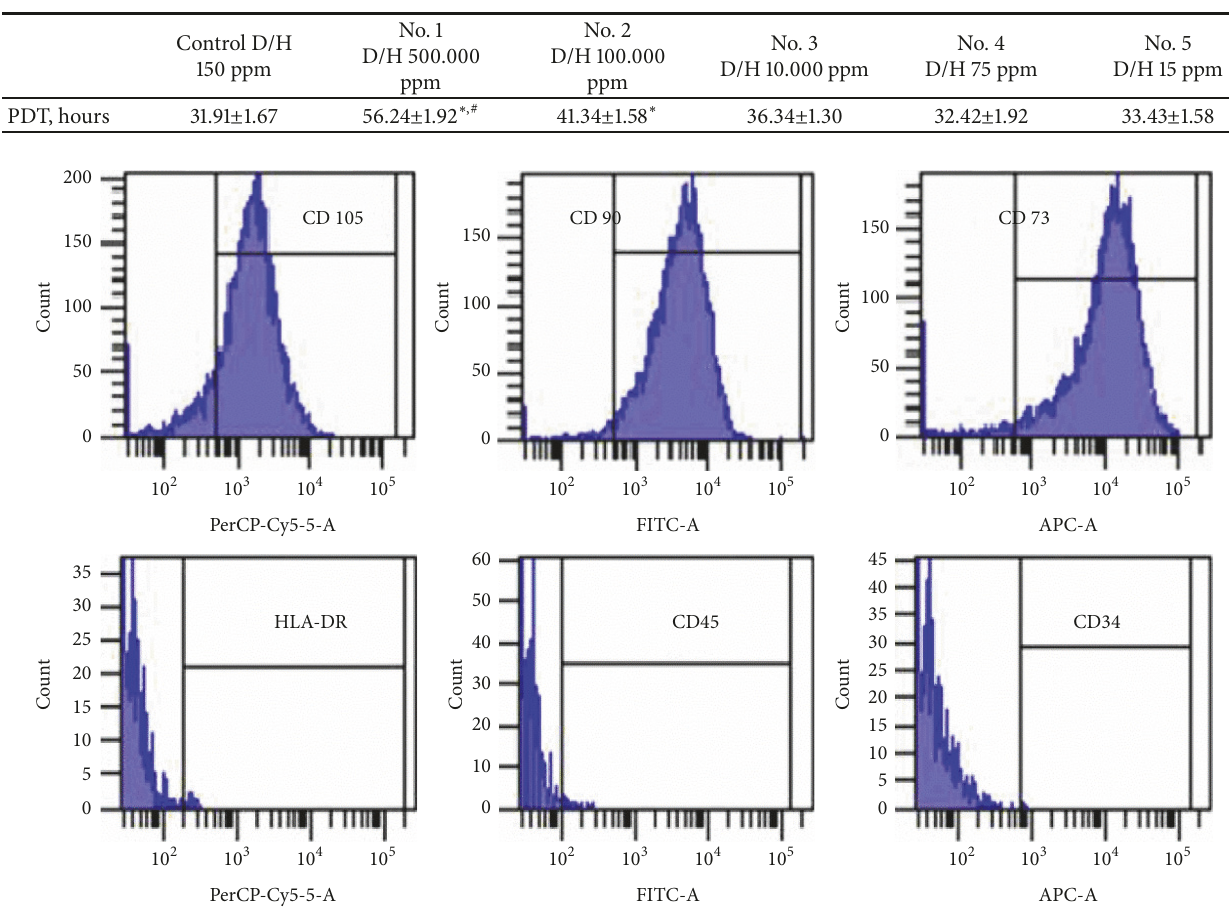
Table 2: ADSCs PDT in growth media with different deuterium content.Theresults are expressed as mean ± SD (n=6), significant differences between the experimental group ∗ p < 0.05 compared to control group; #p < 0.05 compared to groups No. 2-5.).